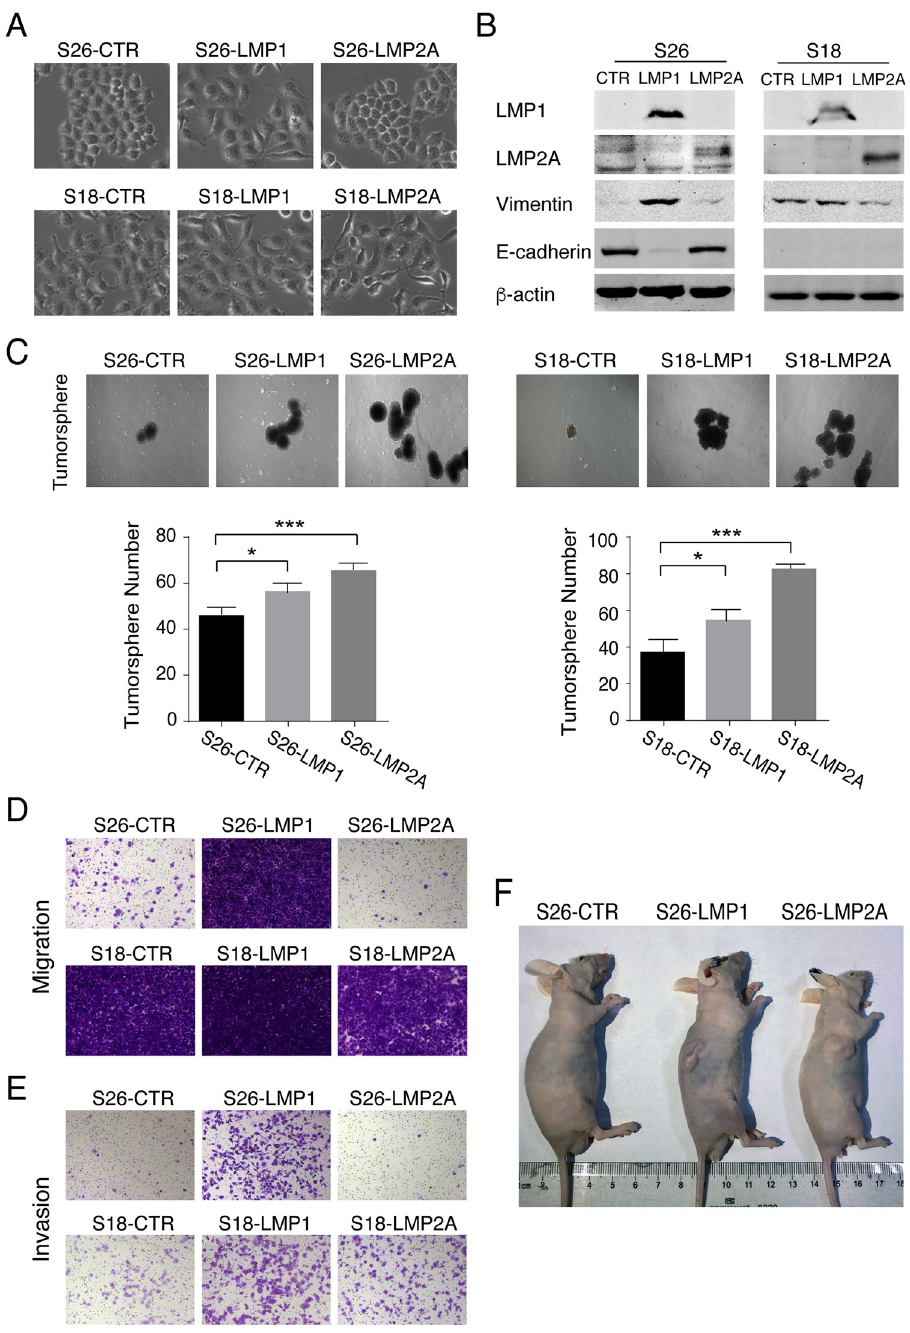
Fig 1. LMP1 and LMP2A enhance the CSC characteristics of NPC cells. (A) Morphological appearance of CNE-2 S26 and CNE-2 S18 cells and morphological changes of these cells in response to the expression of EBV latent membrane proteins LMP1 or LMP2A (200x). ( B) Western blots of LMP1 and LMP2A, as well as EMT-associated markers Vimentin and E-cadherin. ( C) Effects of LMP1 or LMP2A expression on tumorigenicity of S18 and S26 cells were assayed by tumorsphere formation assay. The numbers of tumorspheres of each sample were quantitated and representative images are shown (50x) (Mean+/- SD of three biological replicates, � P < 0.05, ��� P < 0.0001). S18 and S26 cells and cells expressing LMP1 or LMP2A were assayed for their migration and invasion abilities using Transwell migration assay (D) and Transwell-Matrigel invasion assay (E) . Representative images are shown (100x). ( F) S26 cells (S26-CTR) and S26 cells expressing LMP1 (S26-LMP1) or LMP2A (S26-LMP2A) were transplanted subcutaneously into the right flanks of BALB/C-nu/nu mice. The external views of tumor-bearing mice after 21 days are shown.